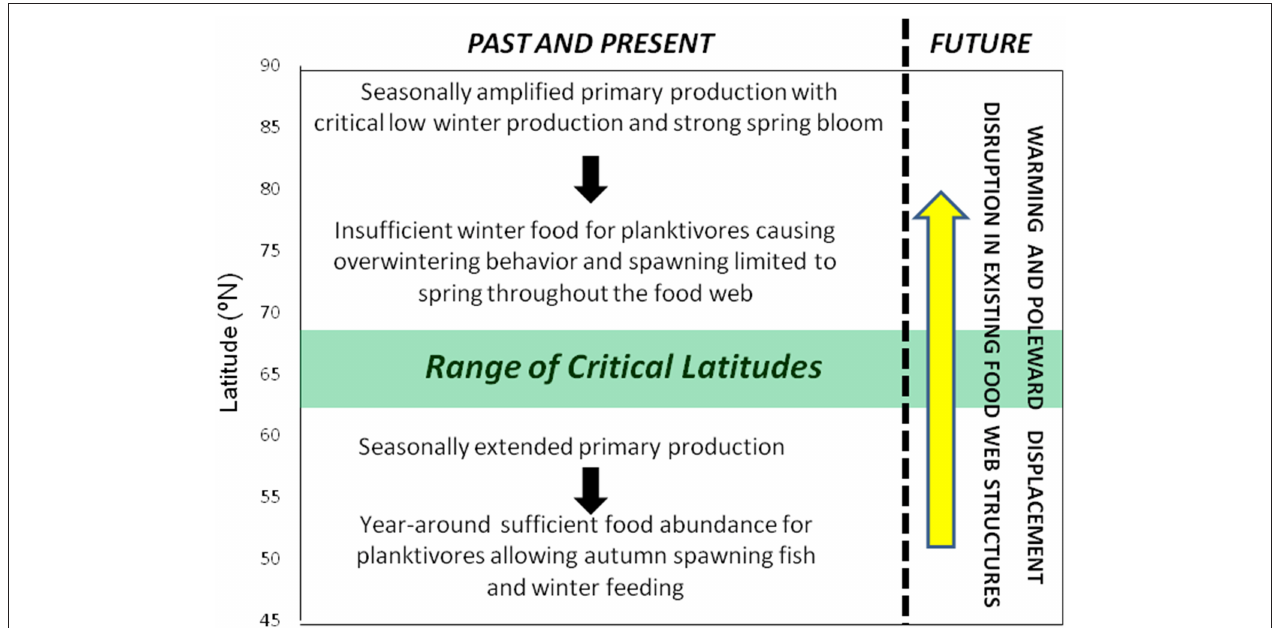
FIGURE 2 | The attributes of the marine ecosystems north and south of the range of Critical Latitudes . North of critical latitudes planktivorous organisms need to develop a specific life cycle strategy to survive the lack of planktonic food during the winter dark. This implies building up lipid storage during the short feeding season during spring to summer and overwintering with reduced metabolism during autumn, winter and early spring to survive the dark season without sufficient plankton production. At higher trophic levels piscivorous organisms that can feed during winter dark are also influenced by overwintering planktivorous, since they have to limit their spawning to the spring time in order to provide planktonic food for their pelagic